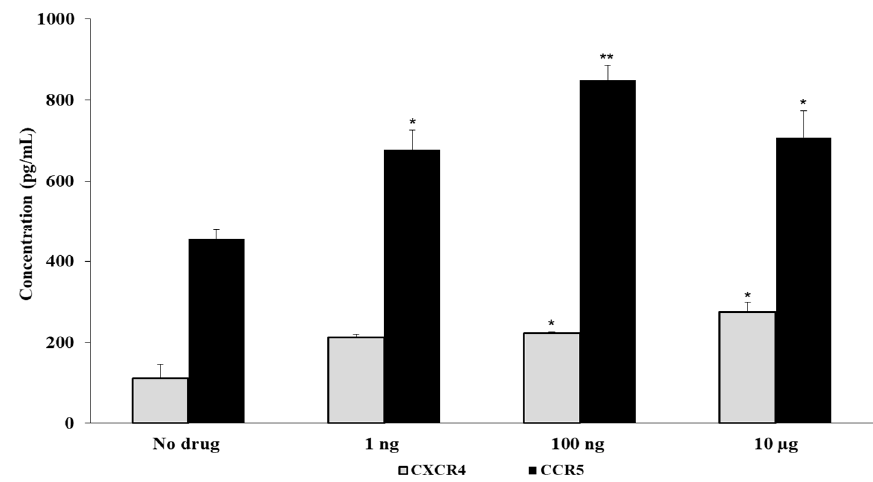
Figure 5. TZM-bl cells were seeded at a density of ~2 × 10 5 cells per well. Fentanyl was added to the culture medium at three concentrations. Post incubation with the drug for 24 h, quanti fi cation of CXCR4 and CCR5 protein levels (pg/mL) was estimated with ELISA in cell culture lysates. ANOVA for dose e ff ect: p = 0.0662 for CXCR4 and p = 0.018 for CCR5. * p < 0.05; ** p < 0.01. To further evaluate the impact of fentanyl on chemokine receptor expression, receptor levels were also quantified in HIV-infected cells exposed to fentanyl. All three HIV-infected cell lines showed signi fi cant increase in expression of CCR5. Expression of CXCR4 was signi fi cantly increased only in ACH-2 and H-9 cells. (Figure 6).